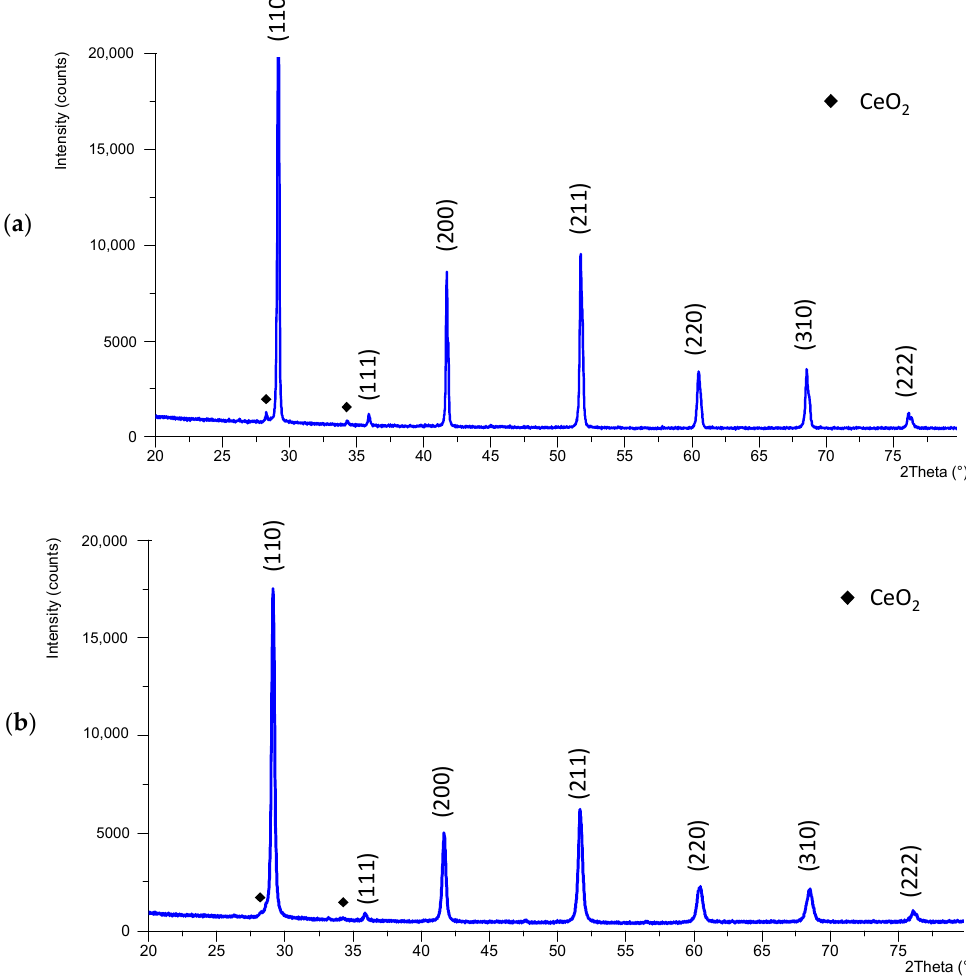
Figure 4. X-ray diffractogram of BCZY pieces after sintering ( a ) BCZY-Pellet and ( b ) BCZY-Crucible.